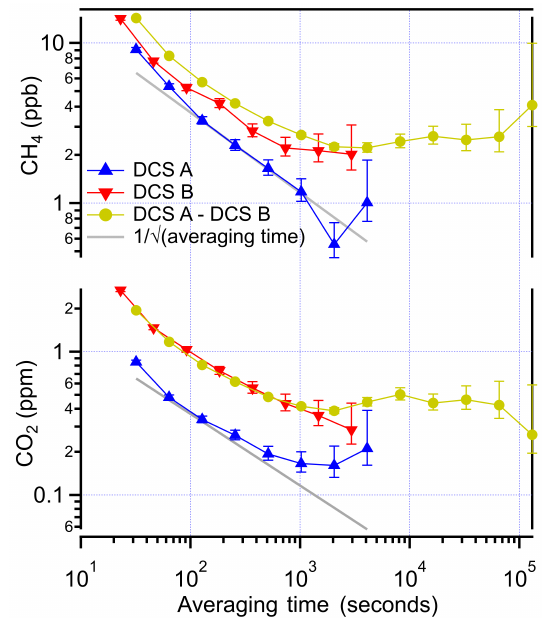
Figure 8. Precision (Allan deviation) versus averaging time, τ , for CH 4 and CO 2 for DCS A (blue) and DCS B (red) over a 2km path for the time period highlighted in Fig. 5. The improved precision of the DCS A results from higher signal-to-noise ratio of the measured spectra. The DCS B precision is slightly better than previously pub- lished precisions from Rieker et al. (2014). The grey line illustrates the slope expected for white noise. For DCS A, at averaging times √ τ for from 30 to 1000s, the precision roughly follows ∼ 40ppb / √ τ for CO 2 (grey lines), where τ is in sec- CH 4 and ∼ 4ppm / onds, before reaching a floor near 1000s. Also shown are the Al- lan deviations for the difference between DCS A and DCS B from Fig. 6 (gold). These differential Allan deviations also reach a floor at ∼ 1000s, suggesting the floor in the individual Allan deviations are due to instrument rather than atmospheric